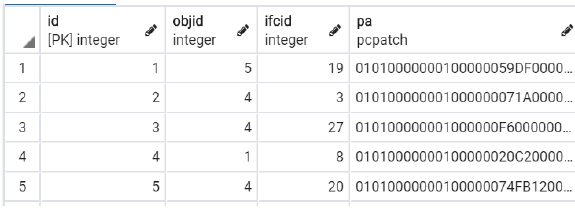
Figure 5. Example of a table created in PostgreSQL to store PAPATCH layout.